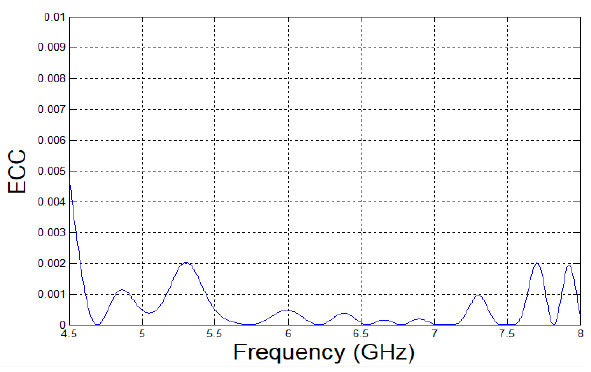
FIGURE 7: ECC of MIMO antenna elements